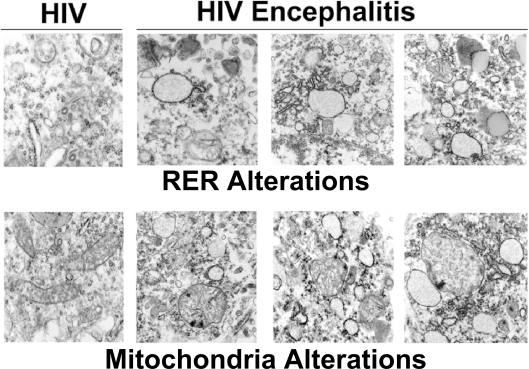
Ultrastructure of frontal cortex from patients with HIVE and dementia.Brain tissue from HIV-1 patients without the neuropathologic hallmarks of HIVE and patients with HIVE and pre-mortem diagnosis of dementia was prepared for electron microscopic analyses as described in Methods. The panels in the montage on the left depict normal neuronal RER and mitochondrial morphology for patients with HIV-1 but no evidence of brain pathology. In contrast, the panels on the upper right depict grossly dilated neuronal RER with scattered deposit of electron dense material and the panels in the lower right depict neuronal mitochondria with abnormal cristae and deposits of electron dense material adjacent to dilated ER cisternae.